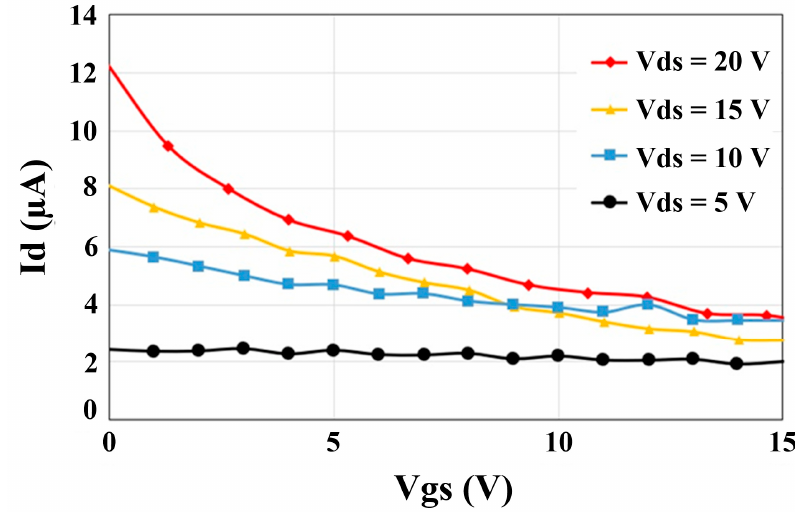
Figure 4. The transfer characteristics of the fabricated phototransistor in dark at different drain–source